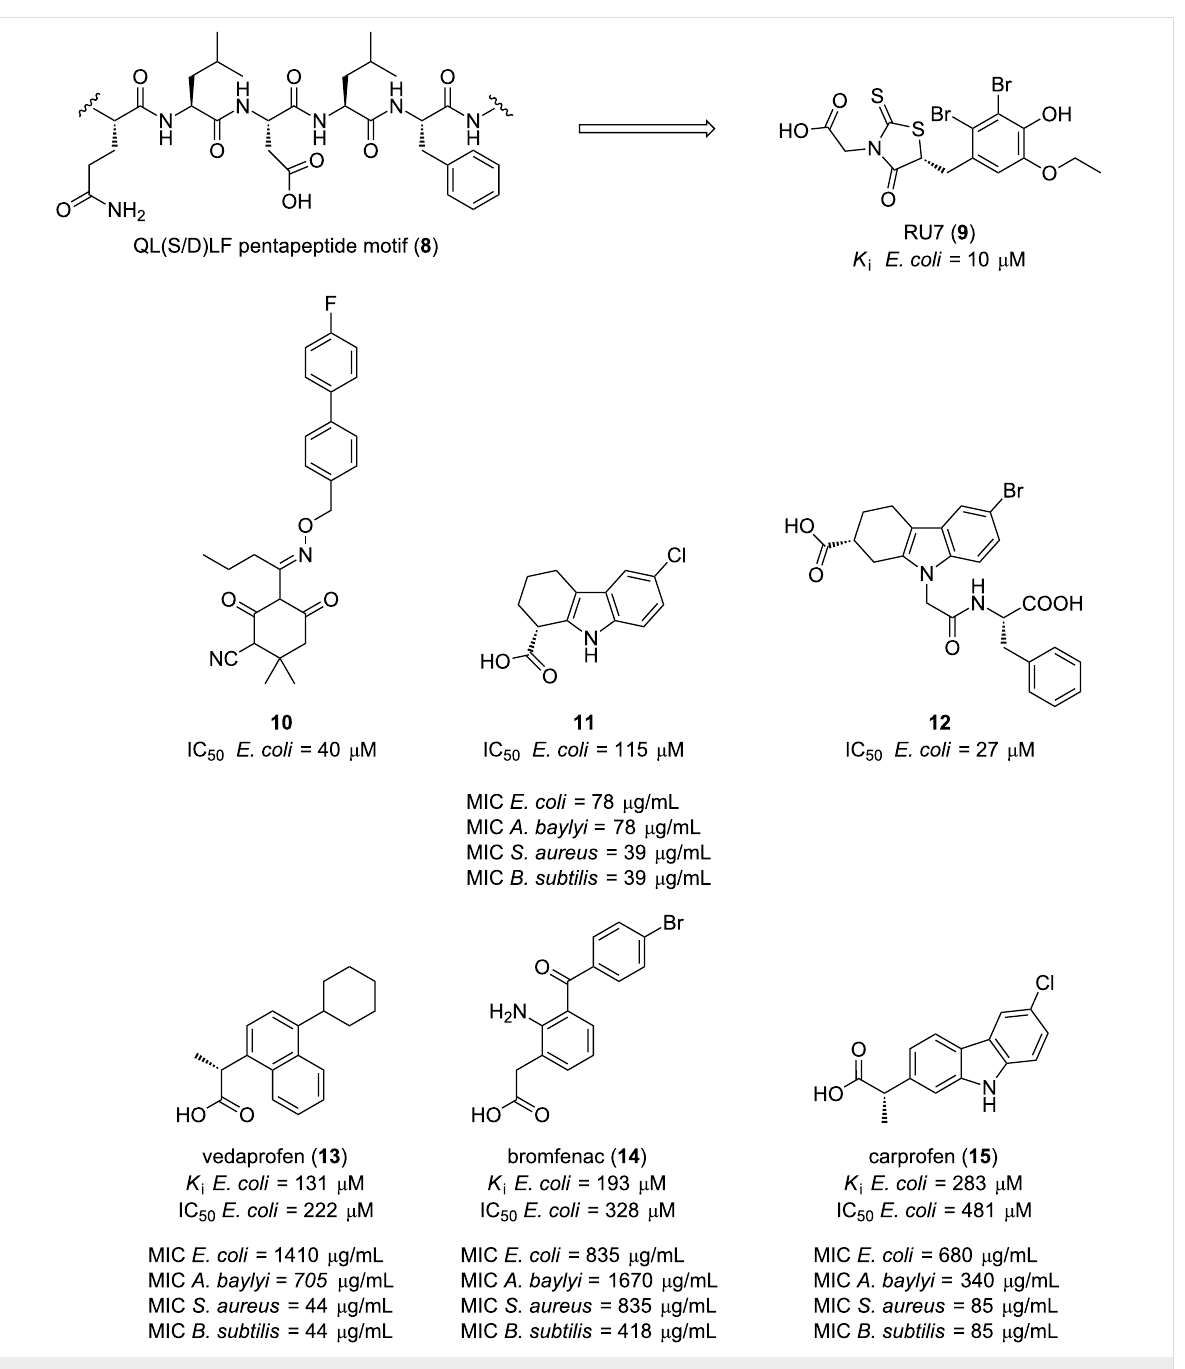
the β -clamp (IC 50 = 1.12 μ M, measured by surface plasmon resonance). This acetylated peptide was used as a lead and further modified at the second position, where the leucine residue was replaced by a cyclohexyl-L-alanyl group (Cha), and also on the terminal phenylalanine benzyl ring, in which two chlorine atoms where incorporated in the benzene ring to achieve P14 ( 17 , Figure 5) with a 15-fold increase of its binding